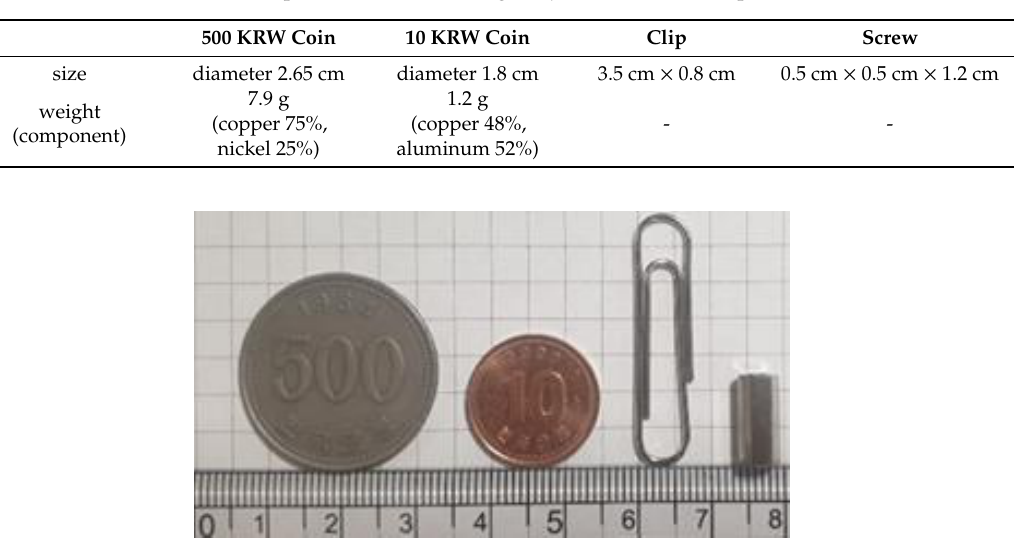
Figure 9. Metal foreign objects used in the experiment.